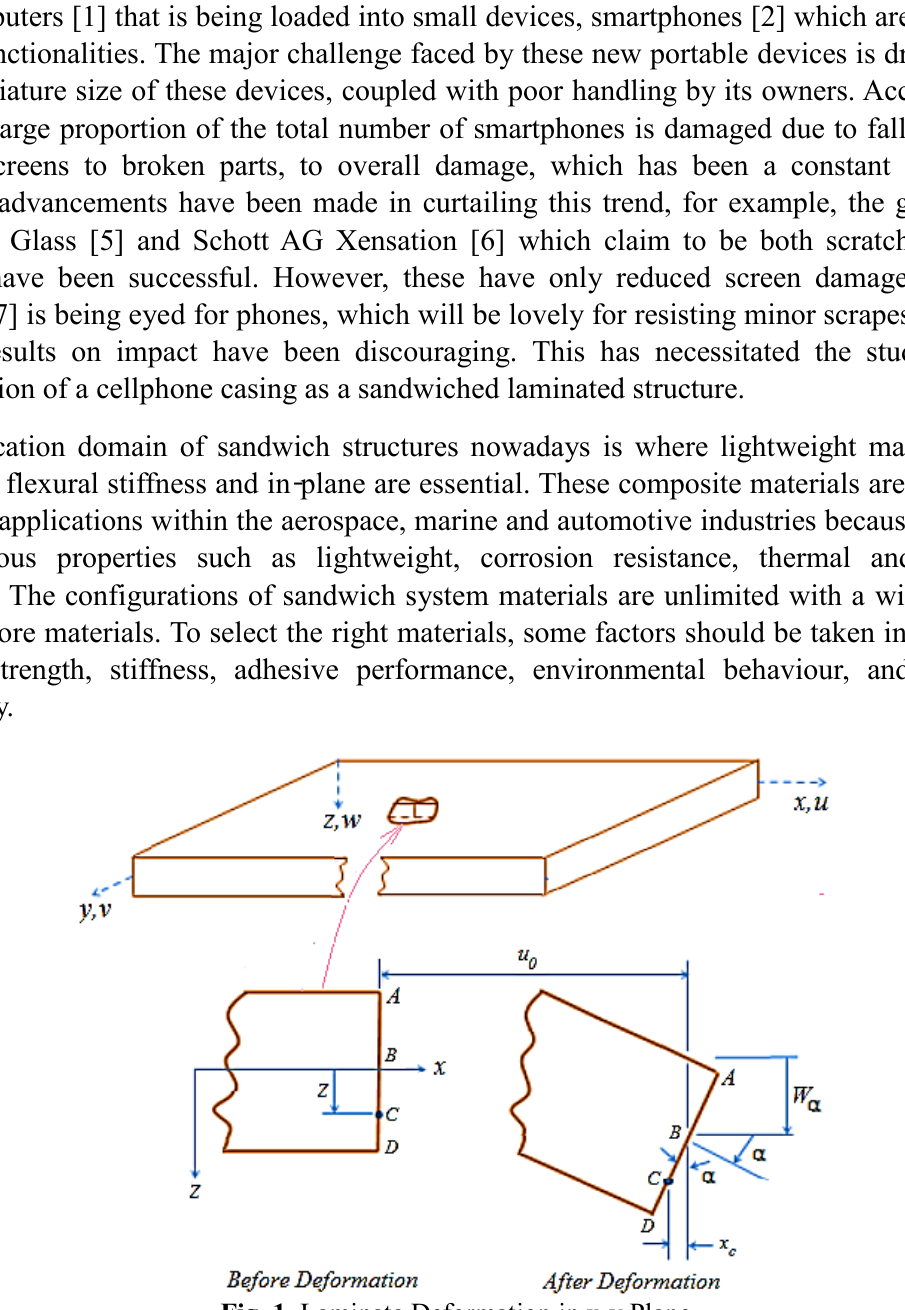
Fig. 1. Laminate Deformation in x-y